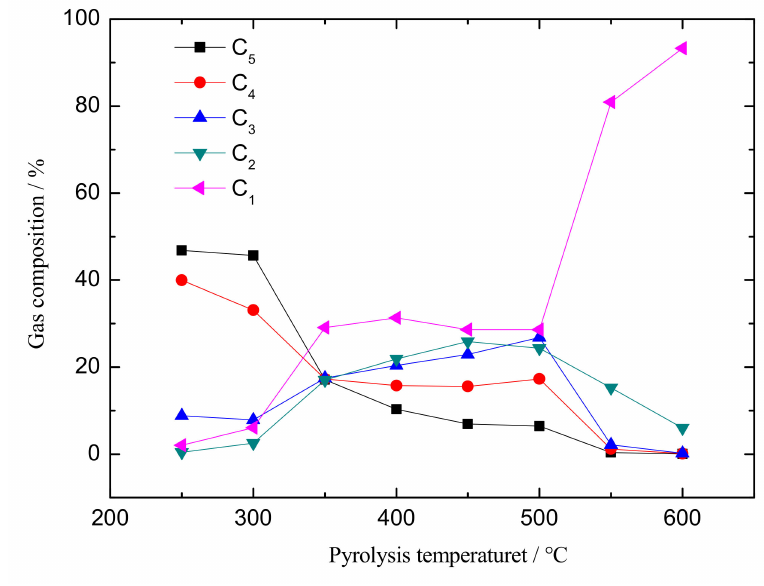
Figure 9. C 1-5 composition of gaseous products at different